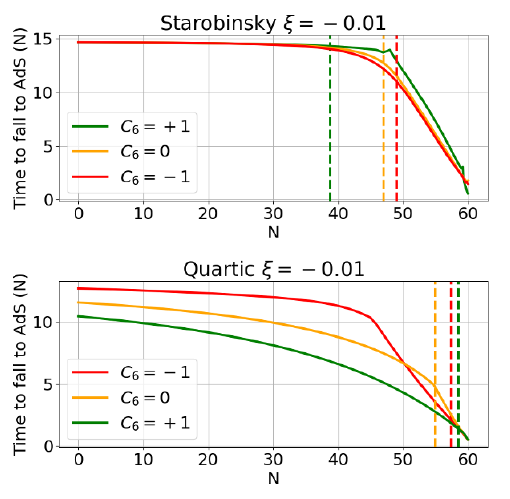
(a) Time needed to form an AdS region versus the number of e -folds. For each scenario, the dashed vertical line indicates the time relevant to compute the fraction of patches in AdS at the end of in(cid:13)ation (see eq. (3.8)).